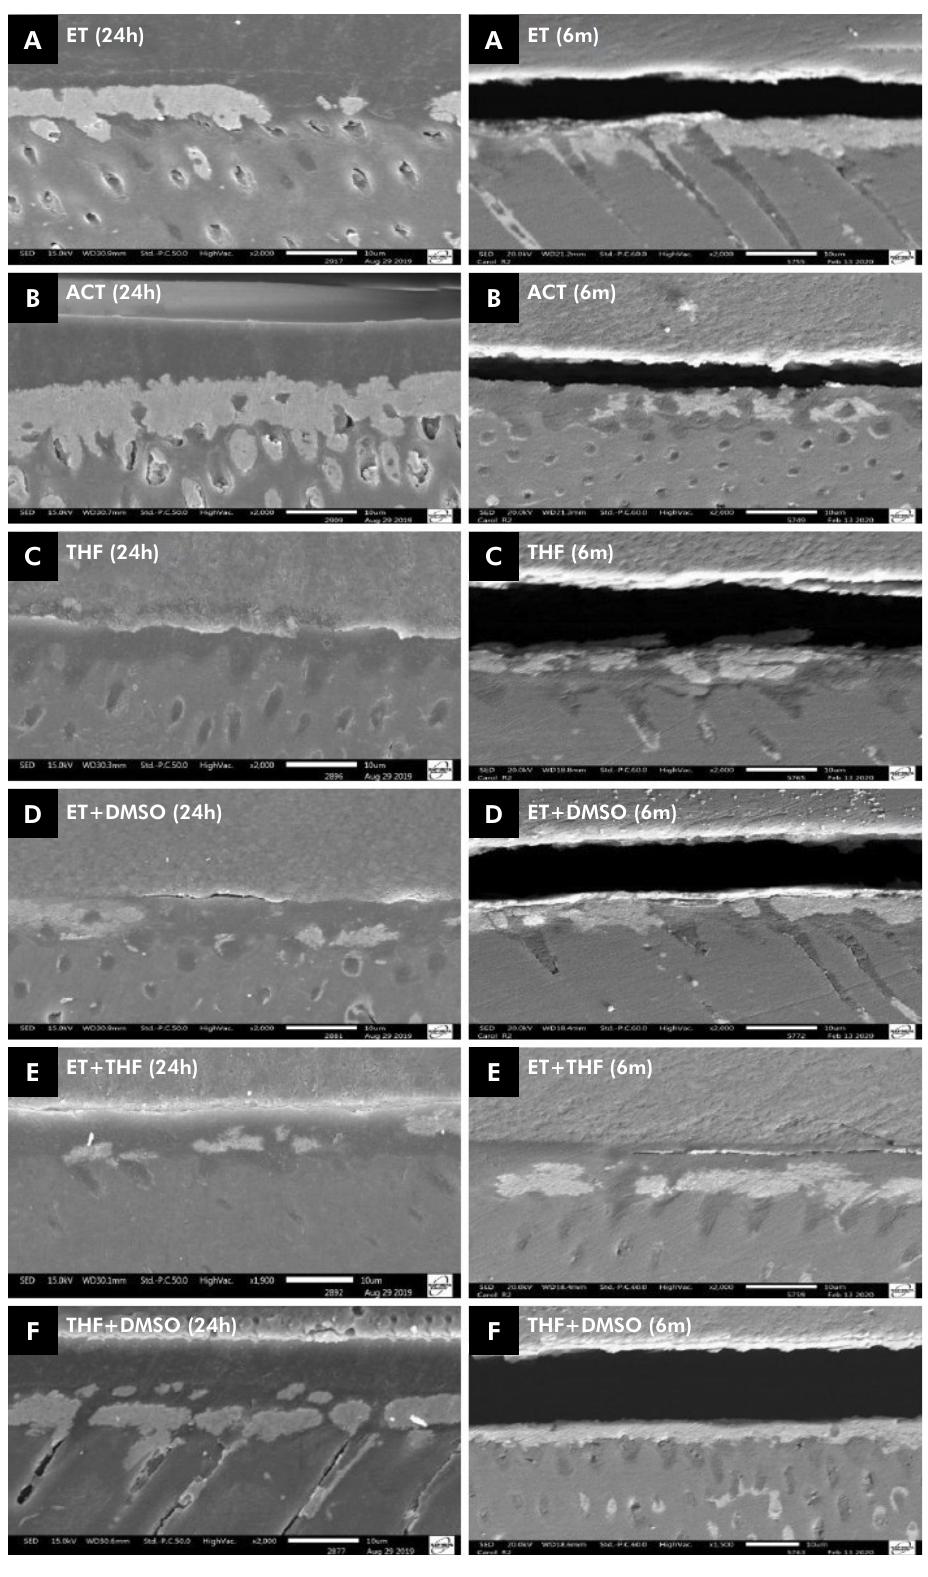
Figure 4. Representative SEM micrographs of silver nitrate impregnation